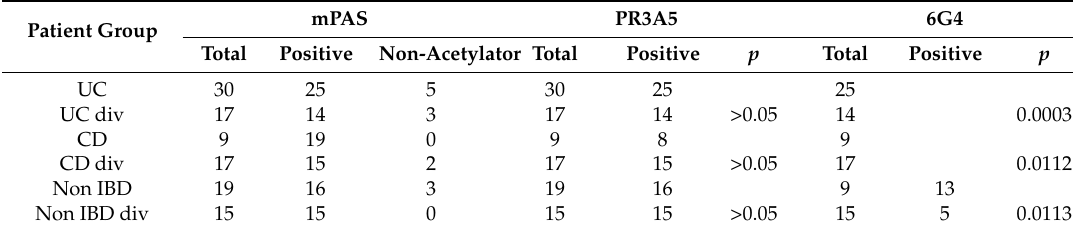
Table 8. Sialic acid O -acetylation in